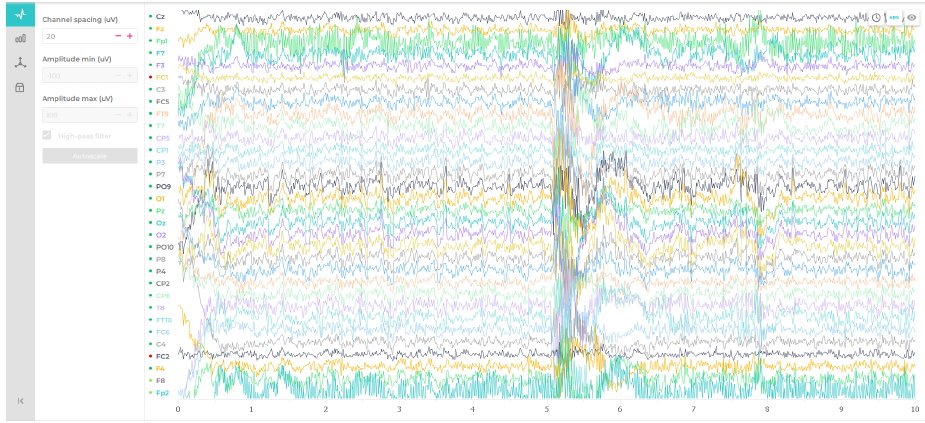
Figure 3. Signal analysis dashboard in EmotivPRO